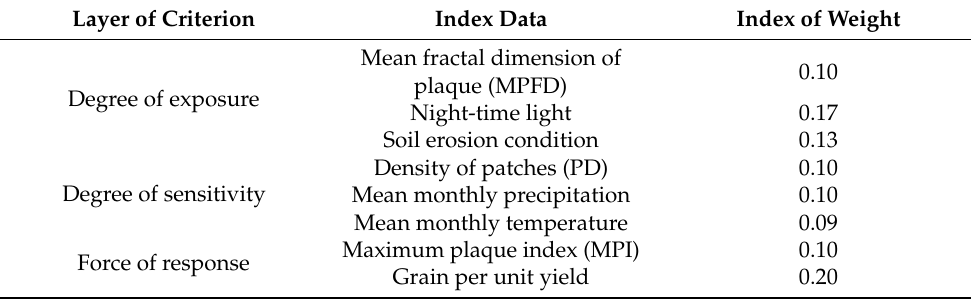
Table 6. The index weight of cultivated land ecosystem